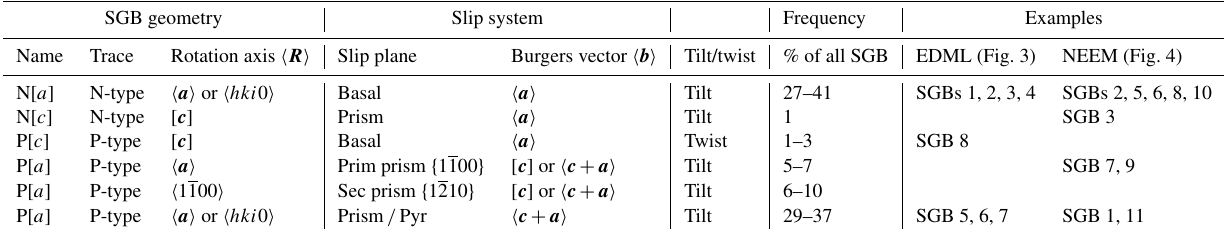
Table 1. Summary and terminology of slip systems interpreted from analyses of LM and EBSD. R is the rotation axis of the subgrain b boundary, and is the Burgers vector for slip. “Prim” is for primary and “sec” is for secondary. “Prism” stands for prismatic and “Pyr” (cid:104) (cid:105) stands for pyramidal.